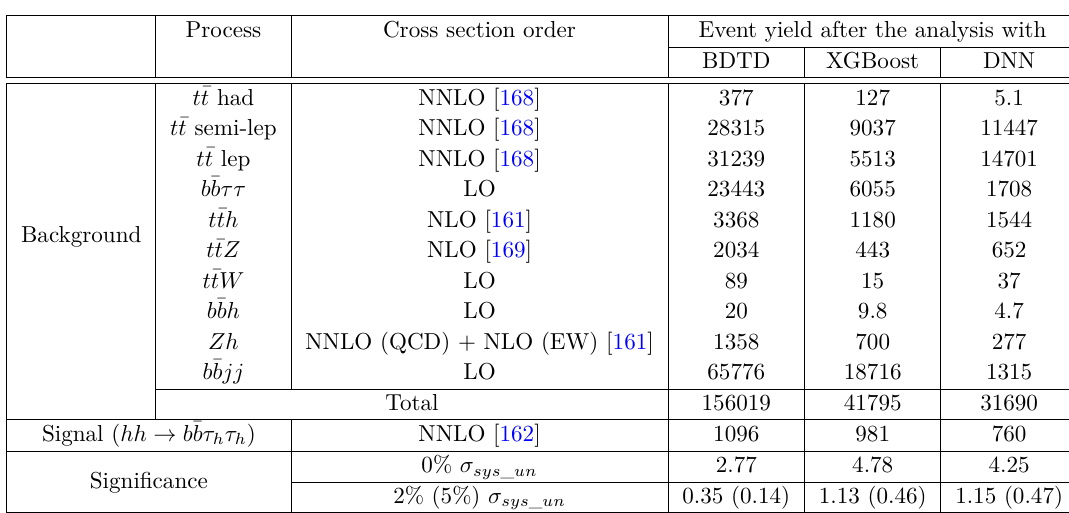
Table 4 . The signal and background yields at the HE-LHC are shown along with the signal significance in the b ¯ bτ + τ − channel from the analysis using BDTD, XGBoost and DNN classifiers.